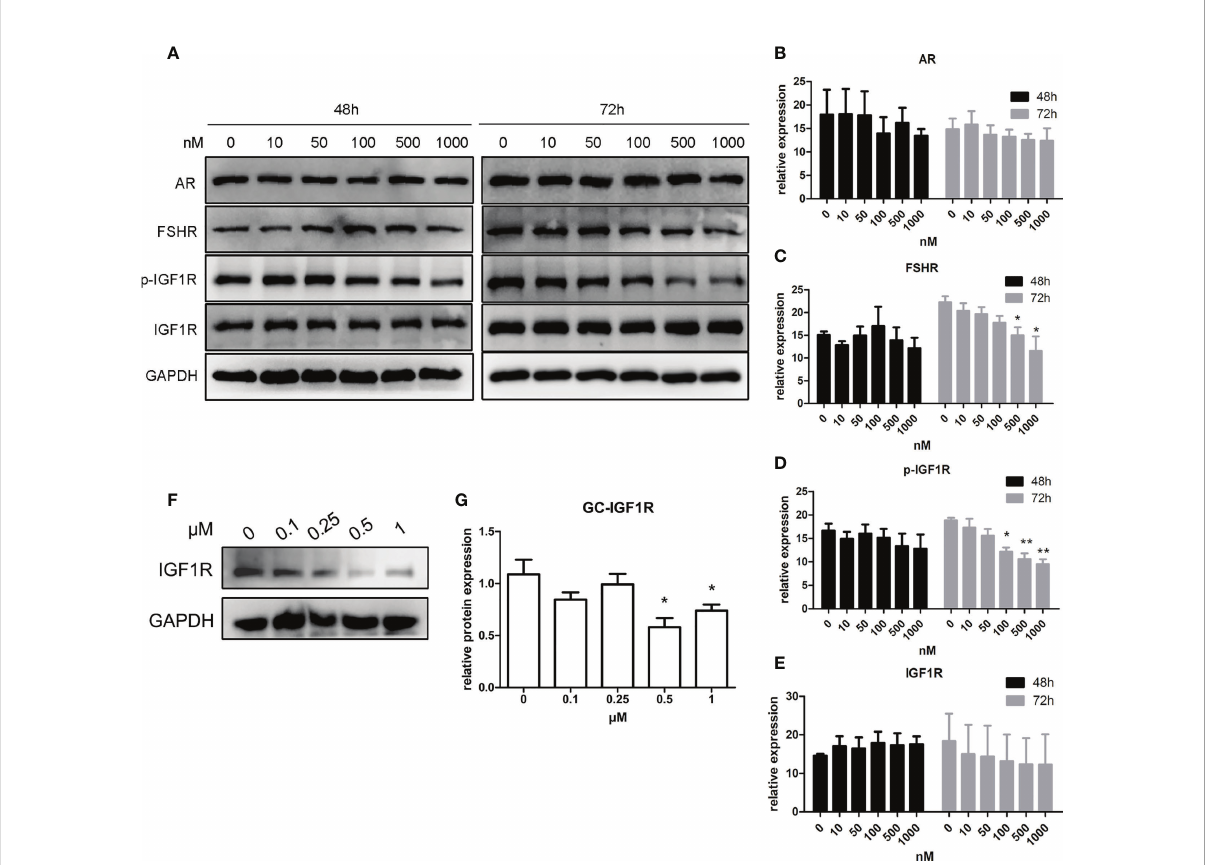
FIGURE 4 Impact of glucocorticoids at different doses on the protein expression of hormone receptors of KGN cells and mGC. KGN cells were treated with solvent or 10, 50, 100, 500, and 1,000 nM CORT, respectively. Protein levels of AR, FSHR, IGF1R, and p-IGF1R were determined by Western blot after 48 and 72 h (A) Semiquantitative analysis was performed after three repetitions. n = 3 in each time point and each group; one-way ANOVA. (B – E) mGCs were treated with solvent or 0.1, 0.25, 0.5, and 1 µM CORTN, respectively, for 72 h Cells were harvested for Western blot analysis of IGF1R (F) and semiquantitative analysis. n = 3; one-way ANOVA. (G) *P < 0.05, **P < 0.01 compared to group “ 0.